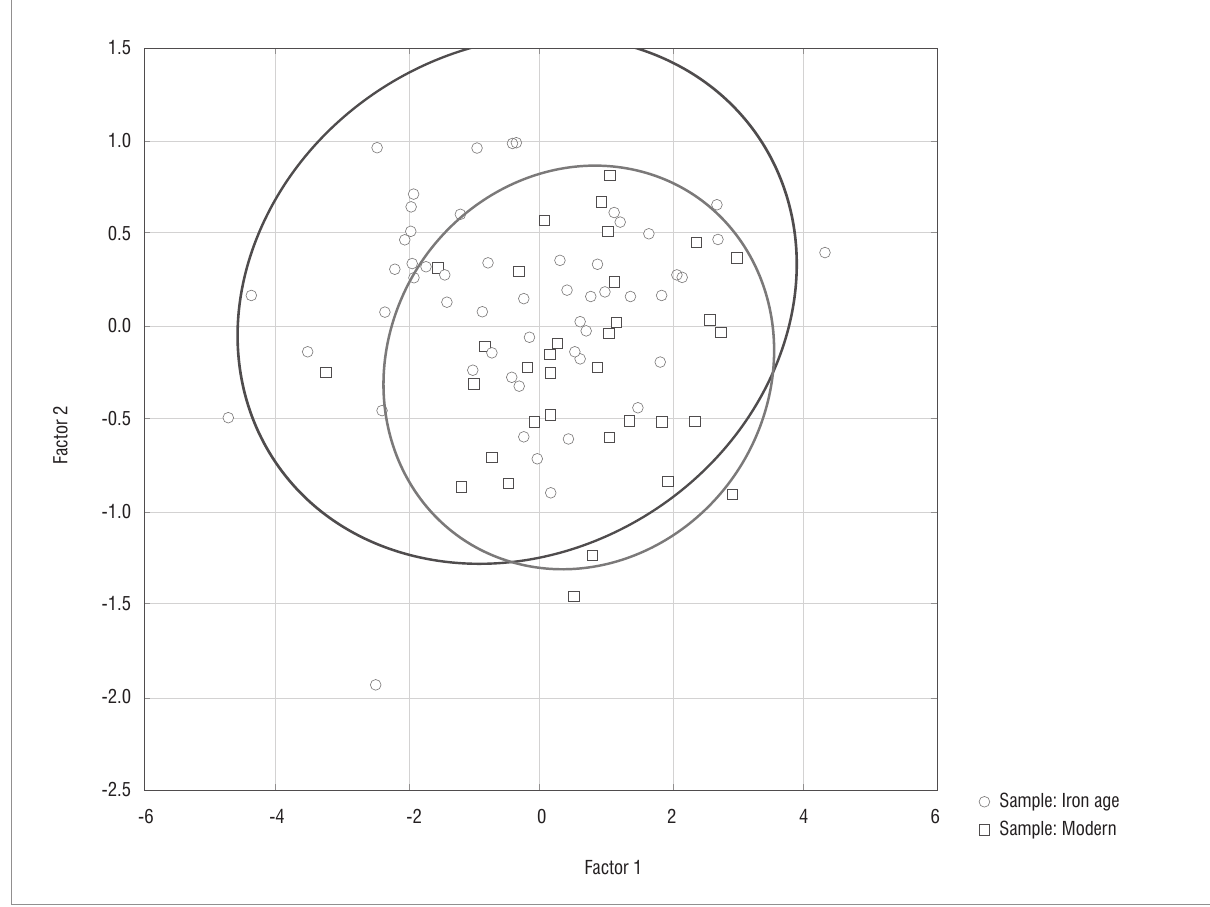
Figure 1: Principal components analysis of dental metric results: scatterplot of factor 1 (67% variance) against factor 2 (7%